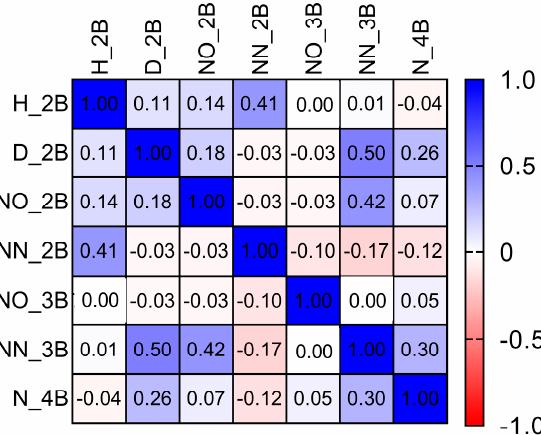
Figure 10. Pairwise Spearman correlation of the morphological features monitored. The scale. Color key scaled from − 1 to + 1 is illustrated as red and blue colors, respectively, with white color representing the absence of correlations. H_2B: height of secondary branches; D_2B: diameter of secondary branches; NO_2B: number of old secondary branches; NN_2B: number of new secondary branches; NO_3B: number of old tertiary branches; NN_3B: number of new tertiary branches; N_4B: number of quaternary branches.